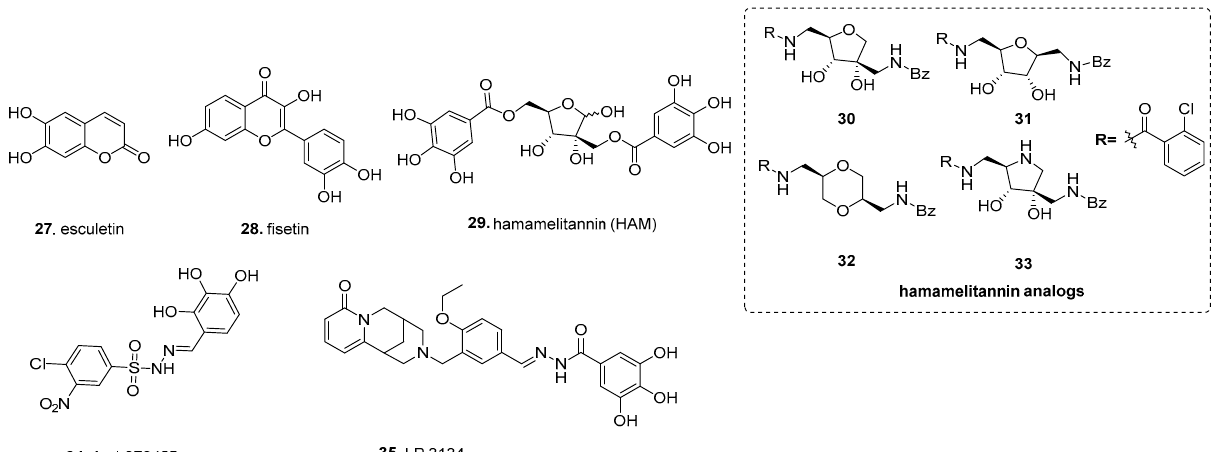
Figure 4. In silico-based discovery of biofilm Figure 4 . In silico-based discovery of biofilm inhibitors